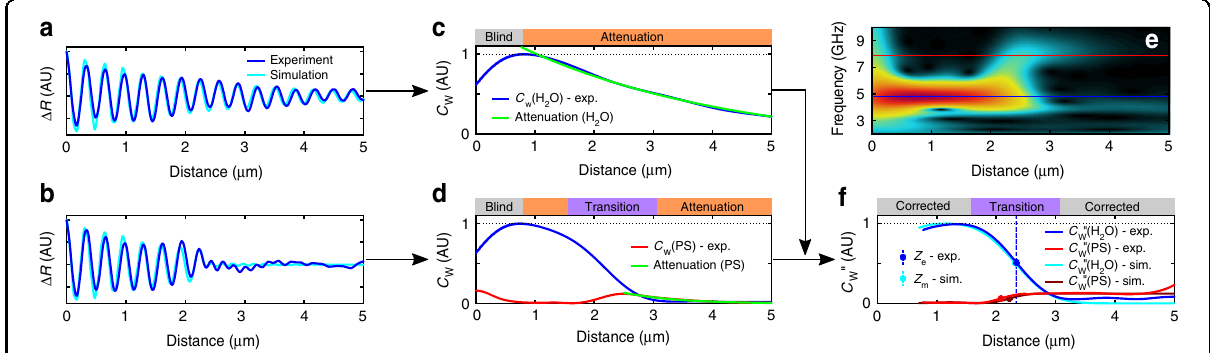
Fig. 2 Proximity measurement protocol for the phonon probe. a A reference signal, when there is no boundary, permits the acoustic attenuation rate of the couplant to be characterised through wavelet analysis (green fi t in c ). b When there exists a boundary, a transition in Brillouin frequency occurs, accompanied by a sharp decay in the amplitude at the carrier frequency (blue in d ) and a rise in the amplitude at the Brillouin frequency of the second material (red in d with green attenuation fi t). e Spectrograph of the signal in b showing the constituent acoustic modes: blue line for ~5 GHz (water), and red line for ~8 GHz (PS). f The attenuation rate of the carrier frequency normalises the boundary decay ( C w ″ , see Eq. (3)); markers indicate the position of 50% amplitude between the absolute minimum and maximum amplitudes of the response, thus providing a proximity measurement from the tip ( z e for experiment and z m for